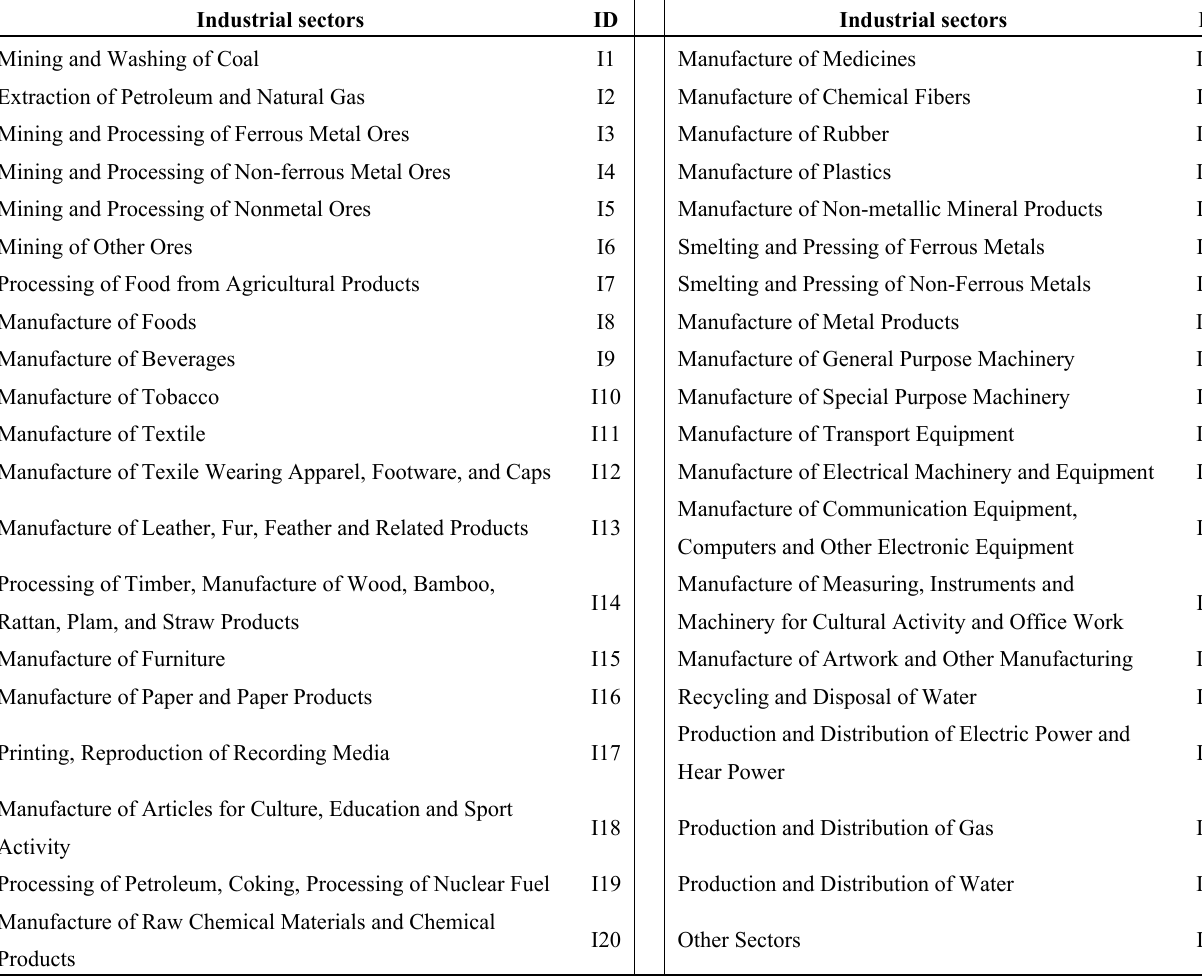
Table A1. Industrial sectors and